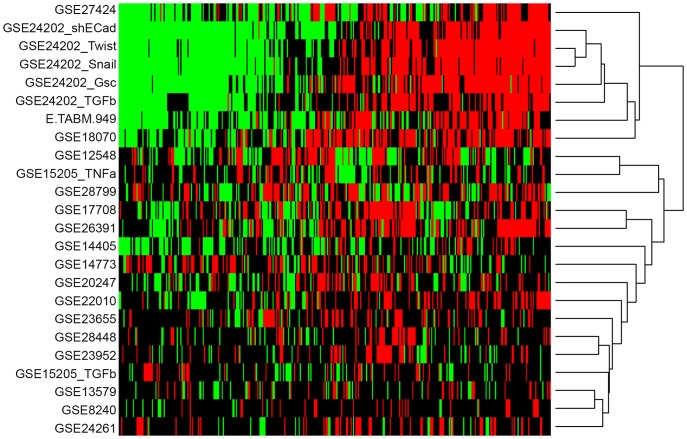
Cluster analysis of genes shared between at least 10 GES datasets shows distinguishable and significant clusters.Genes shared between at least 10 out of 24 datasets were used for Manhattan hierarchical clustering. The type of regulation within a particular study was visualized via heatmap. Columns: genes shared between at least 10 datasets (n = 365); rows: analyzed GES (24 datasets in total); green: downregulated genes; red: upregulated genes; black: genes not regulated. GSE: Gene expression omnibus (GEO) series record; E.TABM: ArrayExpress (AE) series record; TGF, transforming growth factor; TNF, tumor necrosis factor.